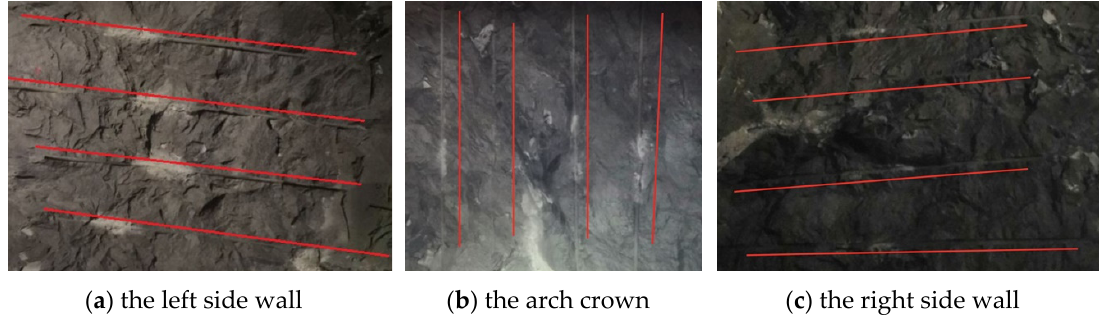
Figure 8. Smooth blasting results from the first test. ( a ) blasthole traces on the left side wall, ( b ) blasthole traces on the arch crown, ( c ) blasthole traces on the right side wall.